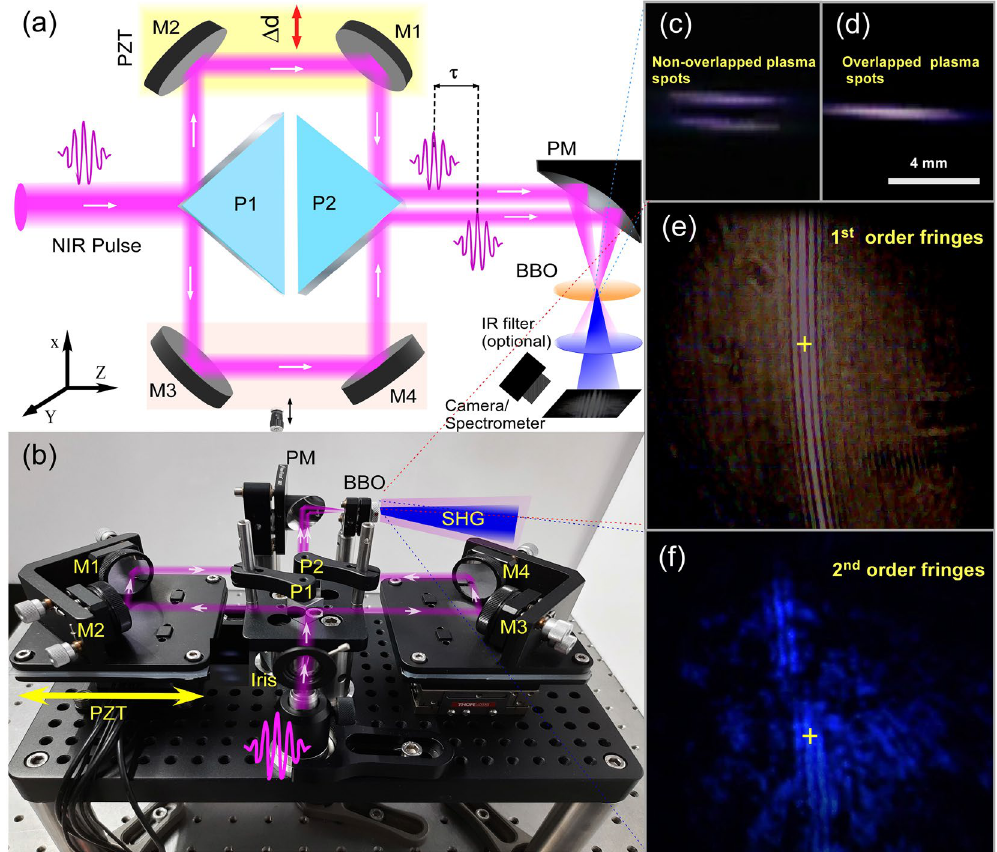
Figure 1. ( a ) Schematics of all-reflective delay line. M1–M4 : broadband mirrors (650–1100 nm), P1 and P2: Ag coated knife-edge prisms for beam splitting and recombination, PM: Parabolic mirror (f = 25.4 mm), M1 and M2 are placed on the piezo stage. ( b ) Picture of all-reflective delay line setup. ( c ) Two non-overlapping micro-plasma spots from individual arms. ( d ) Overlapped microplasma spots ( e ) 1st-order fringes corresponding to 800 nm on screen. ( f ) 2nd-order blue fringes generated by BBO. A spectrometer was used for FROG